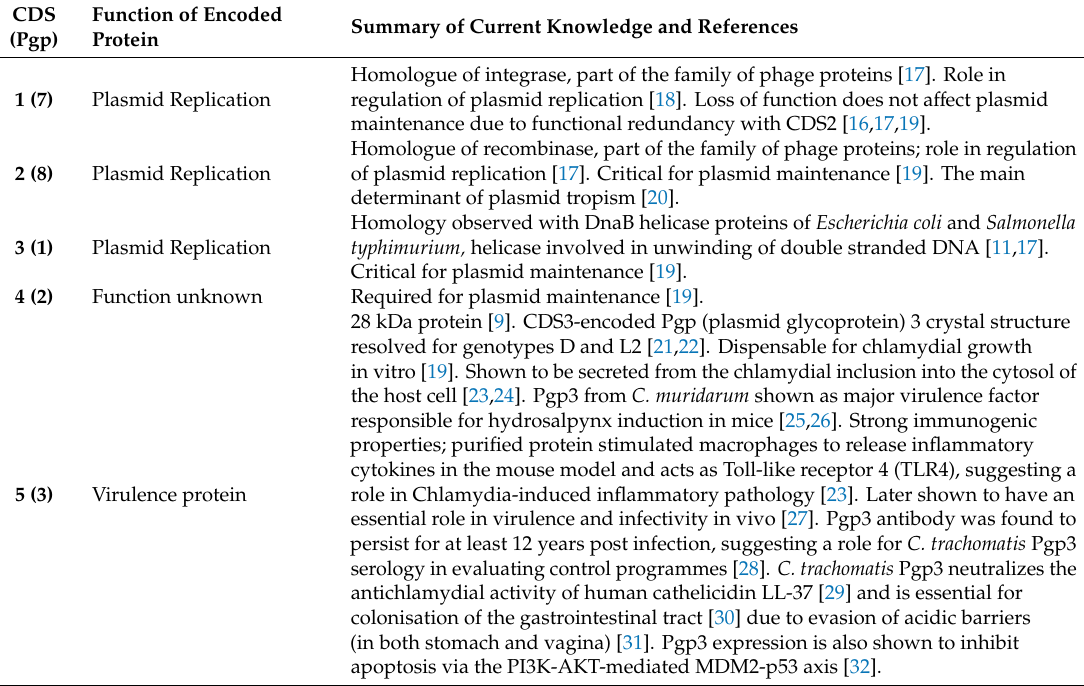
Table 1. Functions of each plasmid CDS and RNA